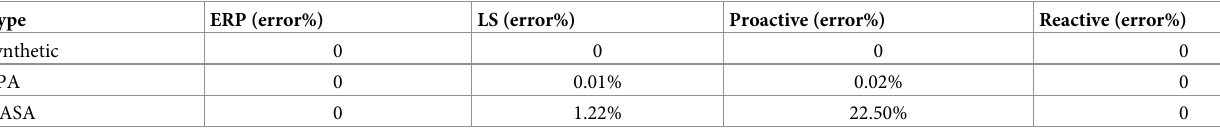
Table 5. The error analysis in the experiments.